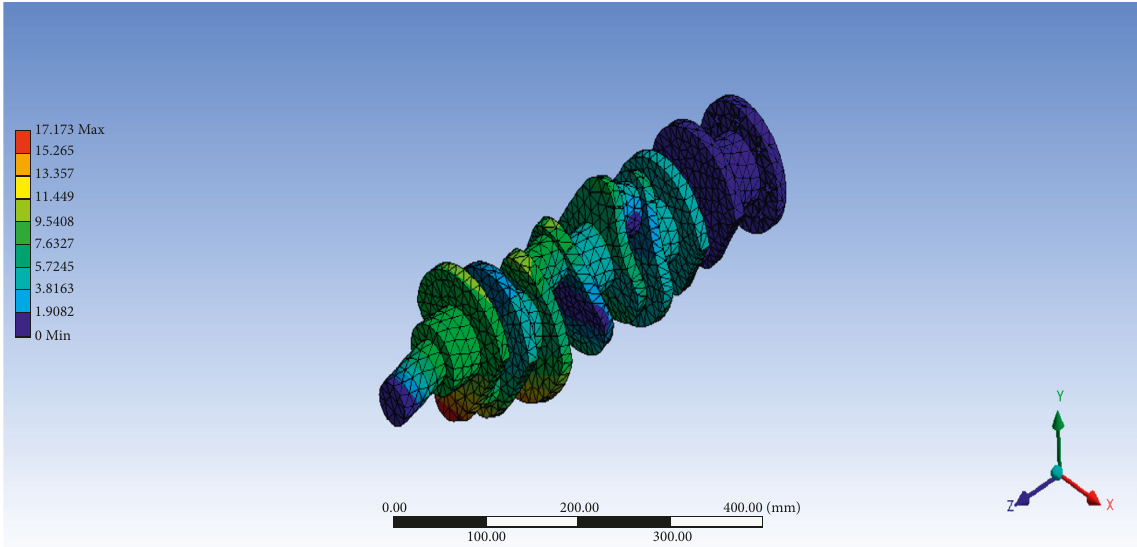
Figure 9: Deformation of stainless-steel crankshaft at the sixth mode of